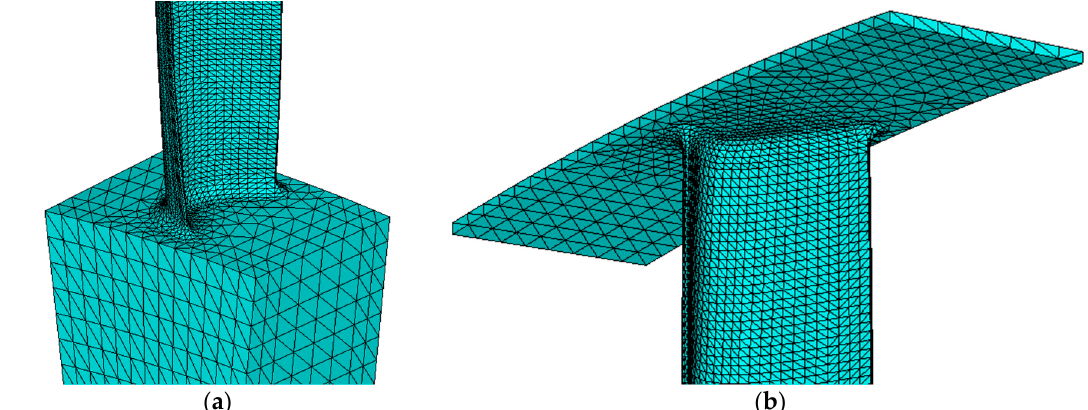
Figure 8. Particular of the Test Case C mesh ( a ) at the blade root and ( b ) at the blade tip (blade-shroud contact area, right).